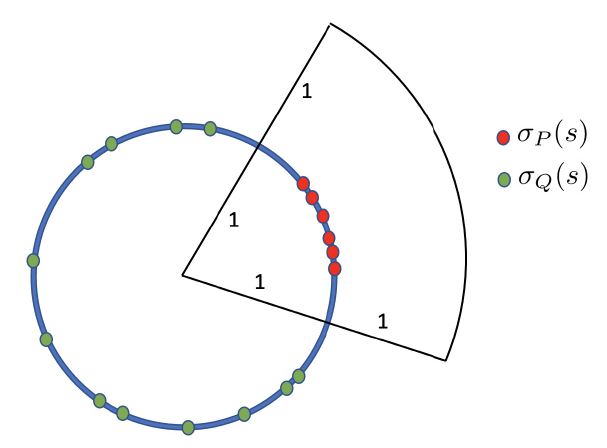
FIG. 1. An illustration of the choice of the contour (cid:11)( s , k ) for k = 0. That is, we consider the eigenvalues for only a single step of the walk. The red dots indicate the spectrum of interest, which will often just be a single eigenvalue; for example, for a ground state. The contour around the spectrum of interest is used to obtain a projector onto the spectrum of interest. For the illus- tration, we use a contour with radius 2 but in practice, we take the limit that the radius goes to